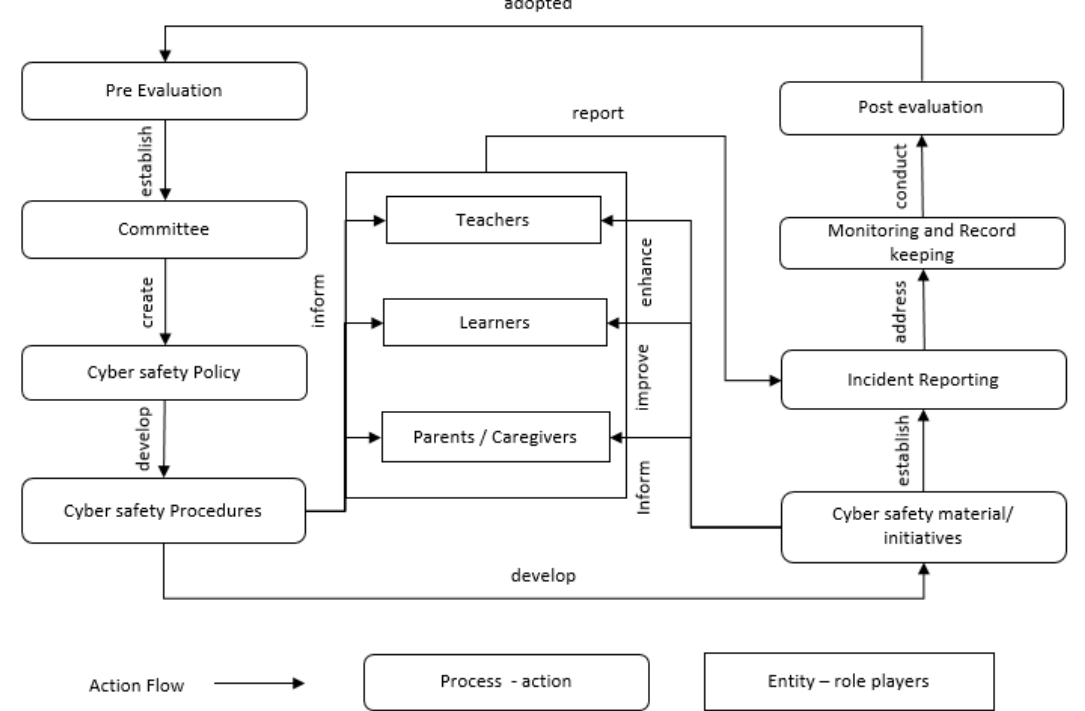
Figure 7. Flow diagram of cybersafety implementation.